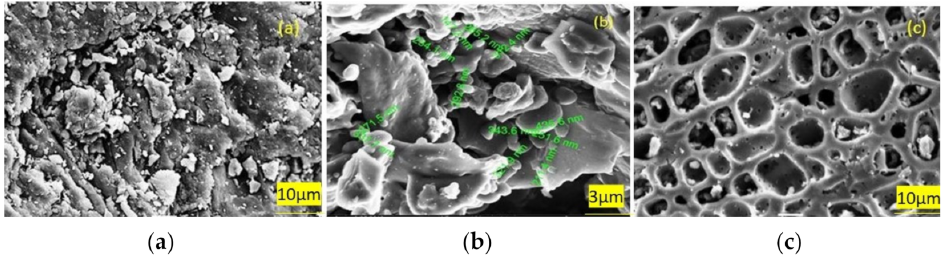
Figure 17. SEM images of ( a ) raw WAS powder, ( b ) carbon black of WAS powder (600 ◦ C), and ( c ) carbon black of WAS powder (800 ◦ C) [86].